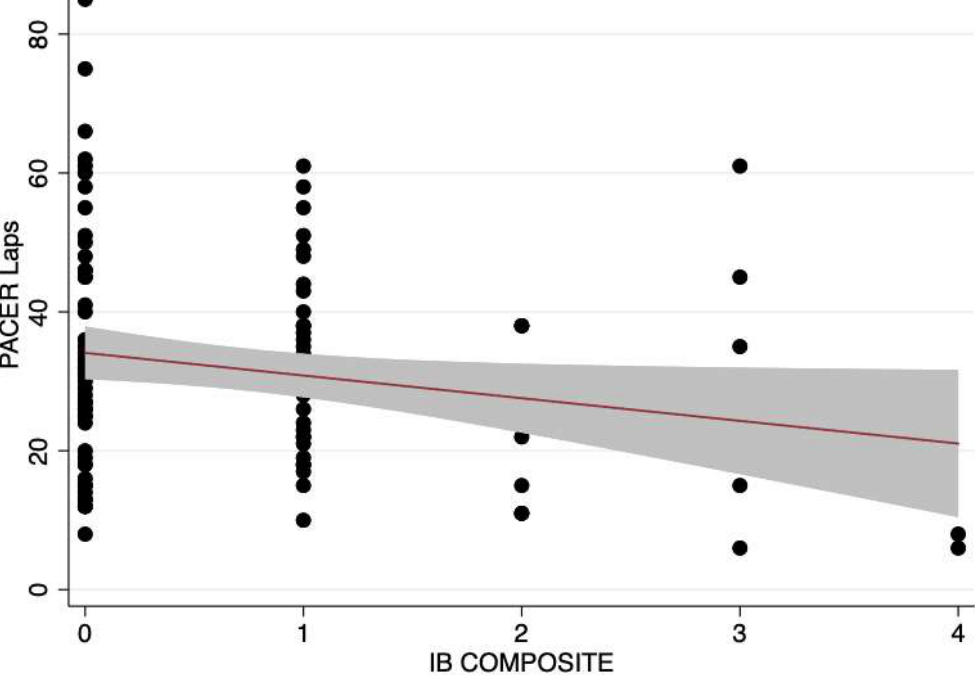
Figure 4. Scatterplot and line of best fit showing the linear relationship between PACER Laps and the number of electronics in the bedroom (IB Composite). Note: PACER stands for the Progressive Aerobic Cardiovascular Endurance Run.